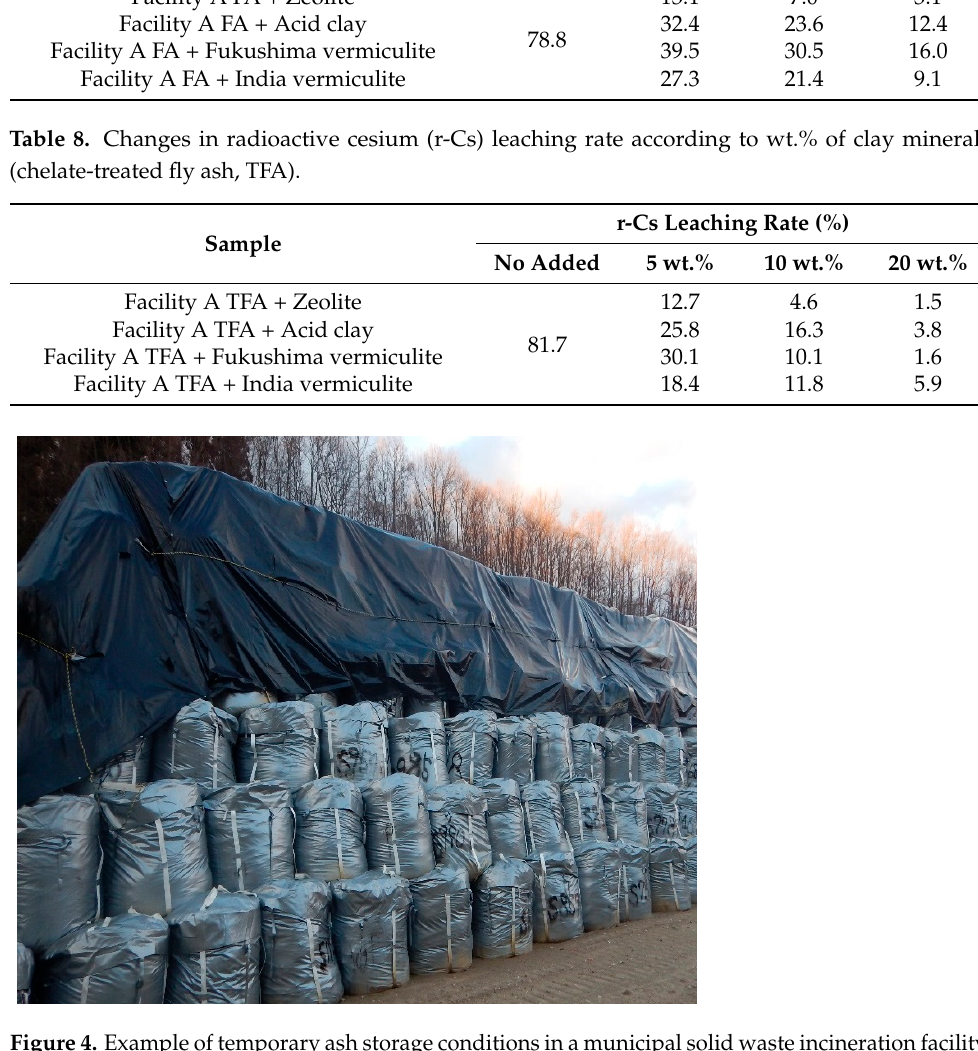
Figure 4. Example of temporary ash storage conditions in a municipal solid waste incineration fa- cility.